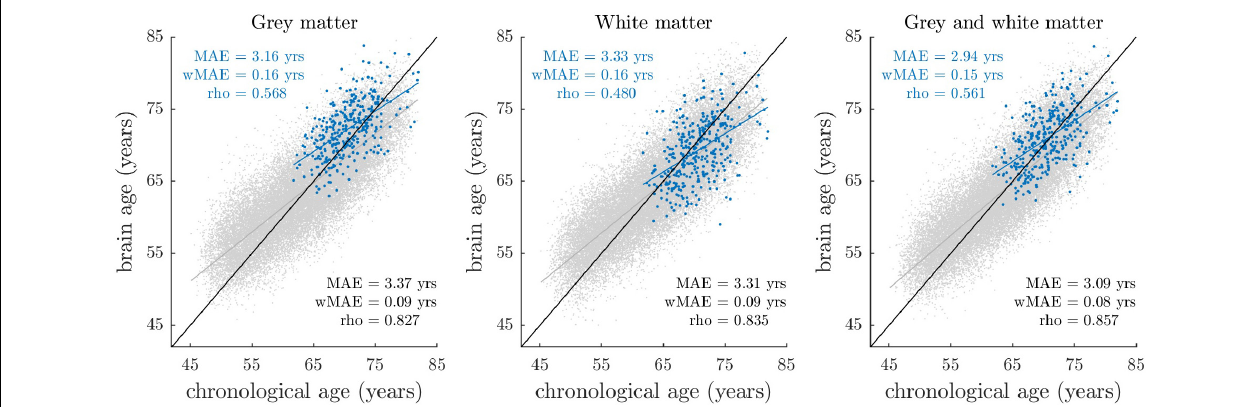
FIGURE 1 | Brain-predicted (“brain age”) vs. chronological age stratified by sample and tissue class. Blue dots reflect the estimates of the BASE-II sample ( N = 335), with their fitted linear regression line shown in blue. Gray dots reflect the estimates of the UK Biobank imaging cohort ( N = 32,634), among whom age estimation models were trained and applied in a 10-fold cross-validation manner. The linear regression line fitted on the UK Biobank data is shown in gray. The identity line (y = x line) is shown in black. At this stage, brain-predicted age estimates have not been corrected for regression dilution, that is, the overestimation of younger participant’s ages and vice versa. Prediction accuracy (blue: BASE-II, black: UK Biobank) was quantified by MAE (mean absolute error between brain-predicted and chronological age), wMAE (weighted MAE defined as ratio between MAE and age range) and rho (Pearson’s correlation coefficient between brain-predicted and chronological